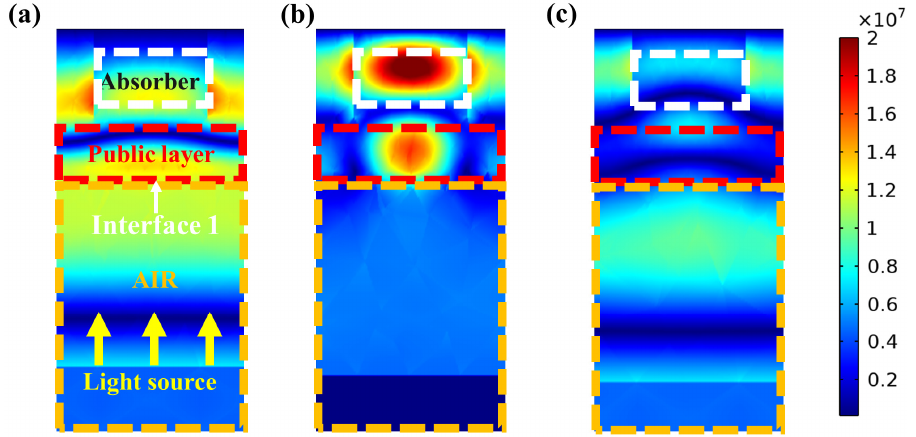
Figure 8. |E x | distribution in XZ cross-sections of the device at ( a ) 10.1 µ m, ( b ) 10.5 µ m, and ( c ) 10.9 µ m of the blue line in Figure 7a.